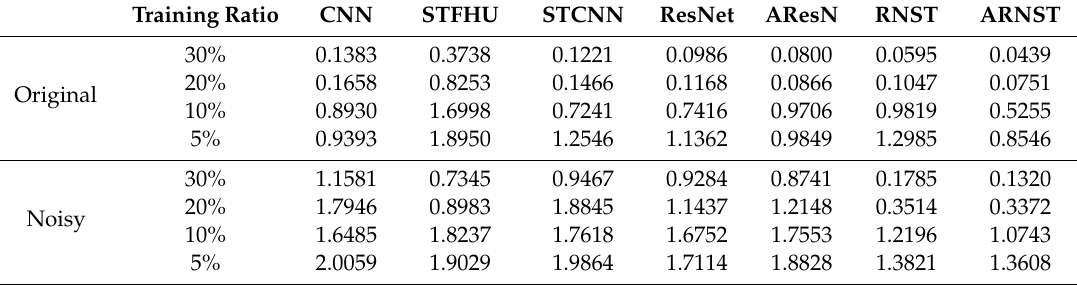
Table 5. Summations of RMSE with small training ratios for the Samson hyperspectral